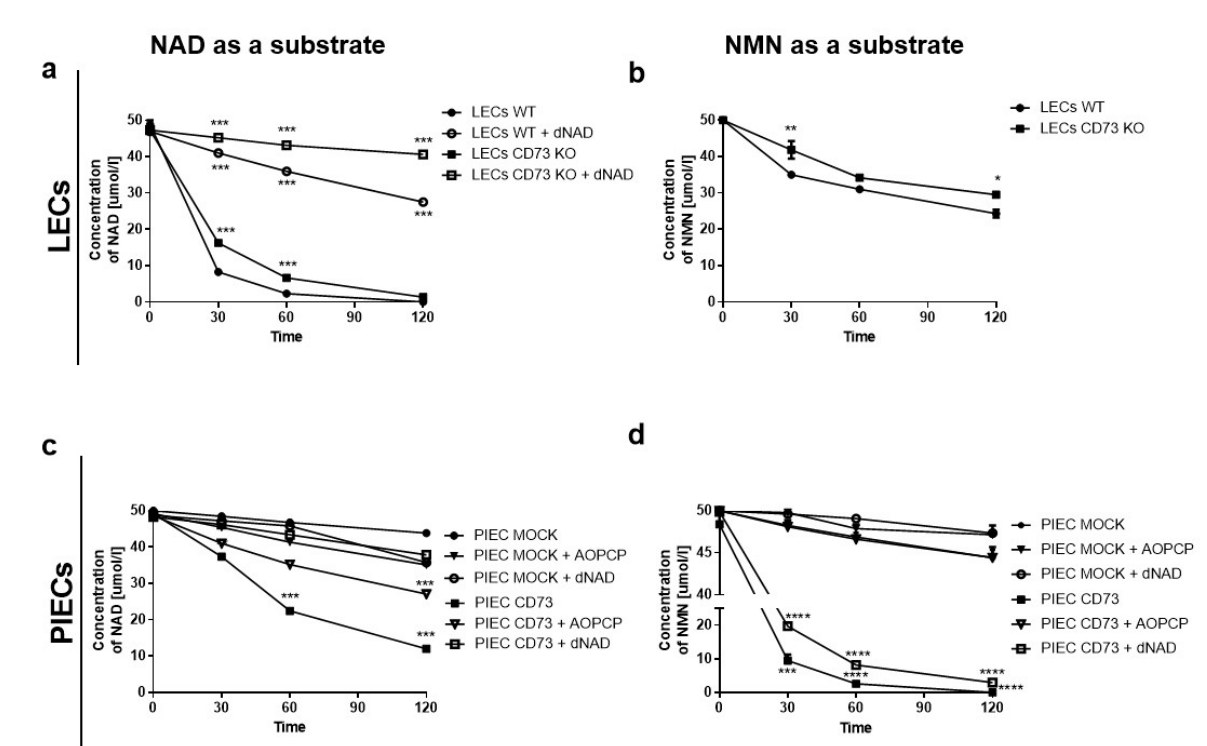
Figure 4. LEC and PIECs characterized by different NAD + and NMN consumption—CD38 is mainly present on the LECs, while CD73 is primarily characteristic of PIEC. Mean comparison of the changes in the NAD + ( a , c ) and NMN ( b , d ) con- centration over time on LECs WT and CD73 KO with an inhibitor of CD38–dNAD + and CD73–AOPCP, and on PIEC MOCK and PIEC CD73 with these inhibitors. n = 3–6; * p < 0.05, ** p < 0.001, *** p < 0.001, **** p < 0.0001 vs. LECs WT or PIEC MOCK with a two-way ANOVA followed by Bonferroni’s